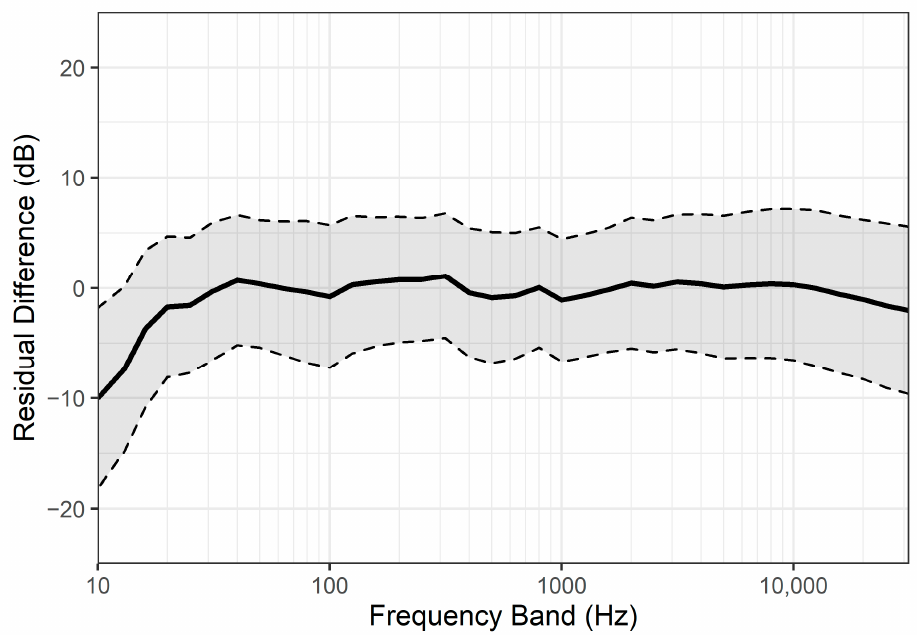
Figure 4. Mean residual differences (solid line) versus frequency between JOMOPANS-ECHO model and the ECHO data set. The dashed lines show one standard deviation of the residual differences about the mean. The mean standard deviation of the residual differences is 6 dB over the frequency range 20 Hz to 20 kHz. Over the same frequency range, the mean absolute value and interquartile range of the residual differences are 5 dB and 8 dB, respectively.